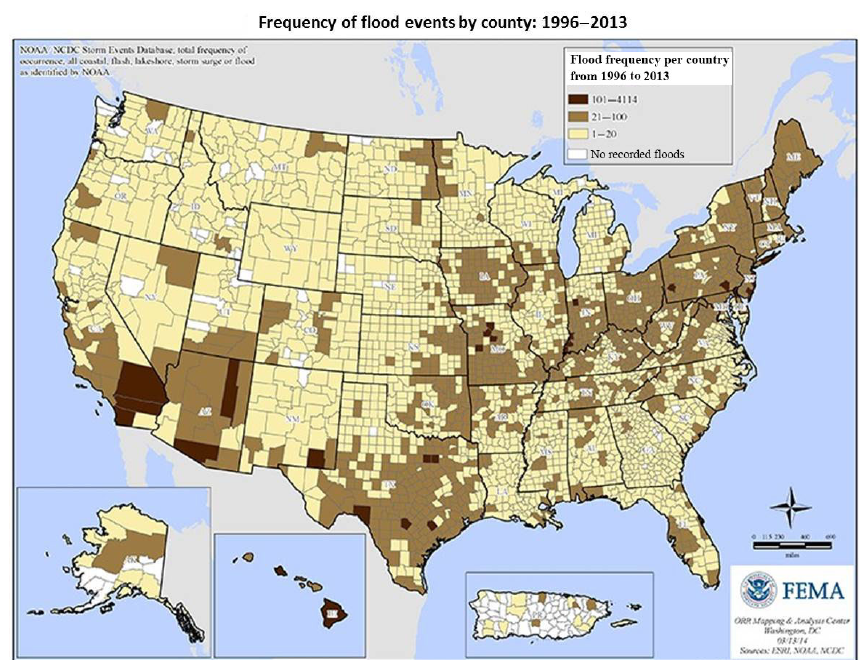
Figure 13. FEMA flood frequency